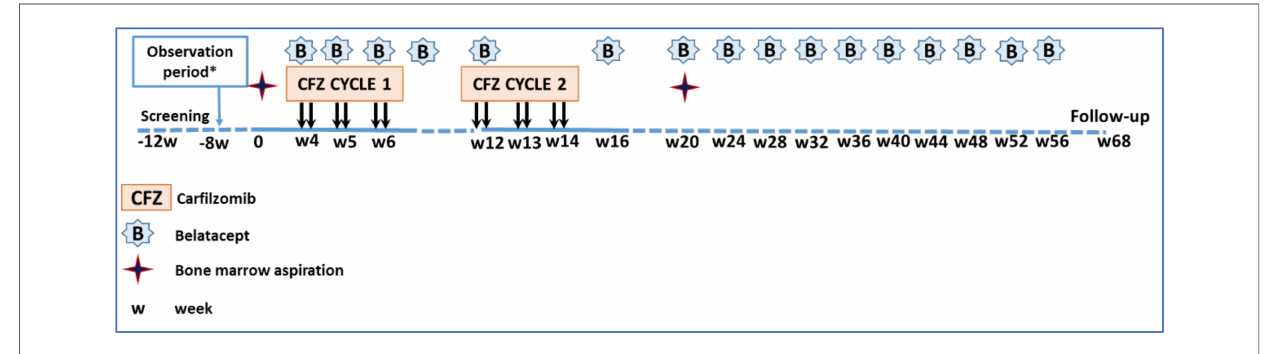
FIGURE 1 Study regimen and timeline. Each ADAPT patient serves as their own control for an initial observation period of 12 weeks to document stable alloantibody levels. Treatment begins with combined car fi lzomib (CFZ) and belatacept ( B ), with the latter continuing for one year to the primary endpoing time. *8 week observation period only in cohort